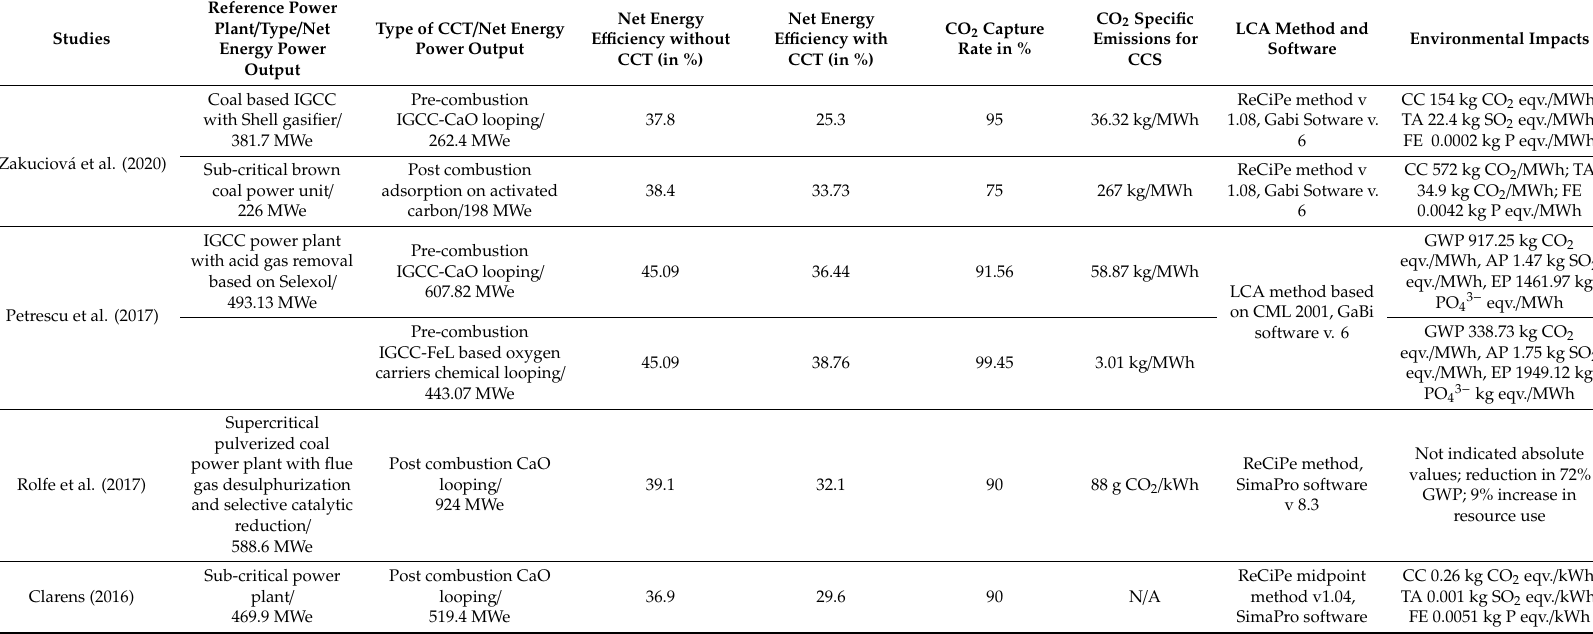
Table 11. Comparison of study results with several references; GWP / CC—global warming potential / climate change; TA / AP—terrestrial acidification / acidification potential; FE / EP—reshwater eutrophication / eutrophication